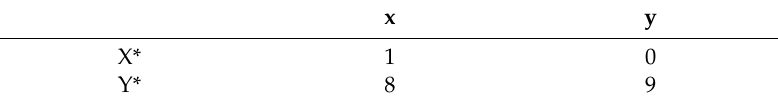
Table 1. The 2 × 2 matrix obtained when comparing the sources “X” and “Y”. x y X* 1 0 8 9